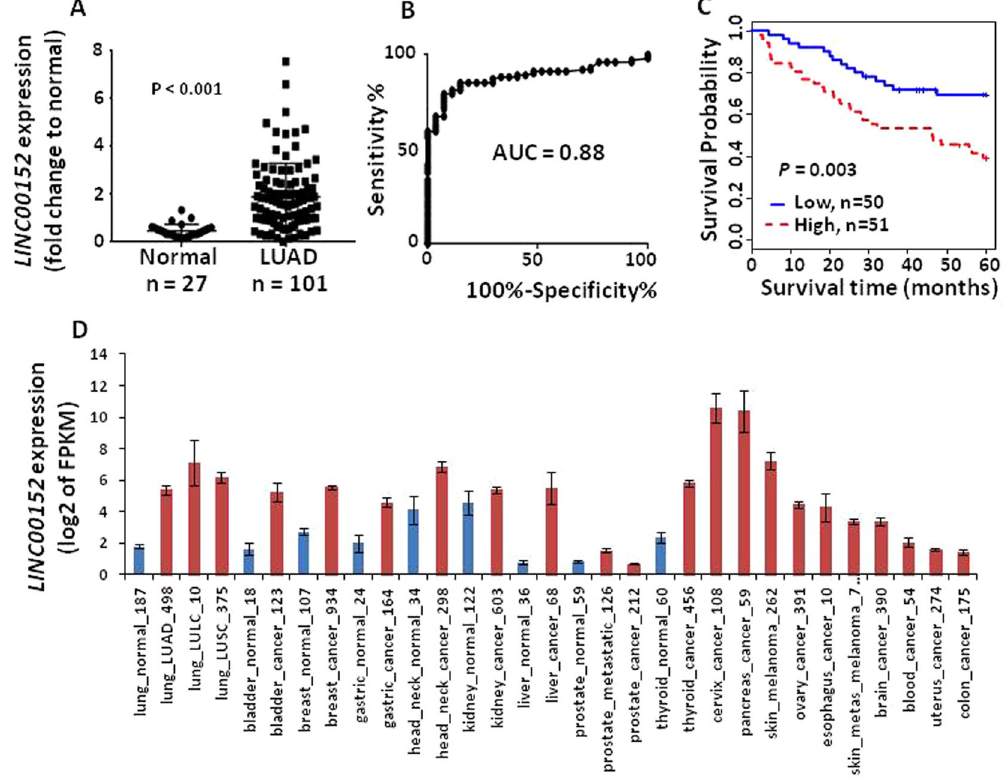
Figure 2. qRT-PCR validation of LINC00152 expression in an independent data set ( A – C ) and LINC00152 expression in other tumors types ( D ). ( A ) Scatterplot indicating LINC00152 expression was higher in tumor (measured by RT-PCR, y-axis is fold change to mean of normal tissues, LUAD vs. normal, p < 0.001 by t test). ( B ) ROC curve indicated an excellent AUC (0.88) for classifying the 101 LUAD from 27 normal lung tissues based on LINC00152 expression. ( C ) Kaplan-Meier curve indicated higher LINC00152 expression was unfavorable for patient survival. ( D ) Comparison of LINC00152 expression in cancers (red) and matched normal (blue) tissues (mean + SEM, log2 of FPKM from RNA-seq data). Lung, bladder, breast, gastric, head and neck, kidney, liver, and thyroid cancers were significantly higher in tumor (vs. normal, t test, p < 0.05). Case number of each cancer is indicated. The original data was downloaded from miTranscriptome with